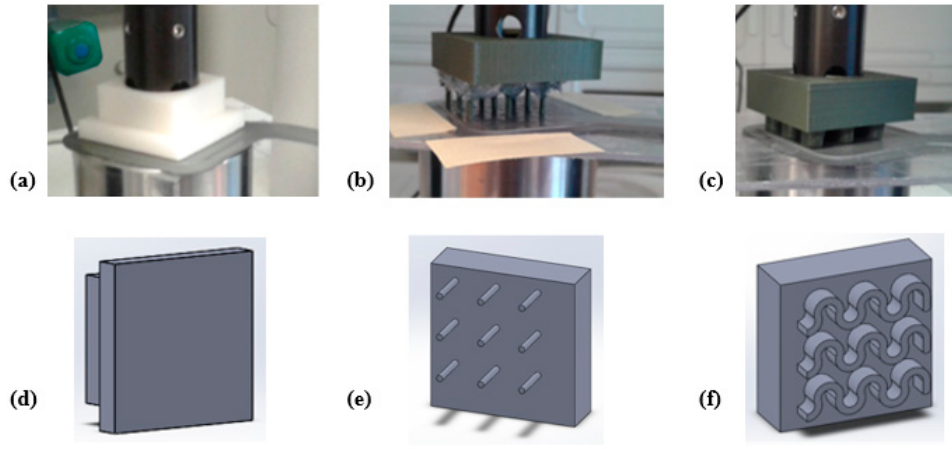
Figure 5. Experimental procedure of coupling between the sensor and the loading probe employed for the three configurations: ( a ) Distributed load; ( b ) 9 Tips load; ( c ) Wave-shaped load. In ( d – f ) is shown the 3D CAD for the three configurations.